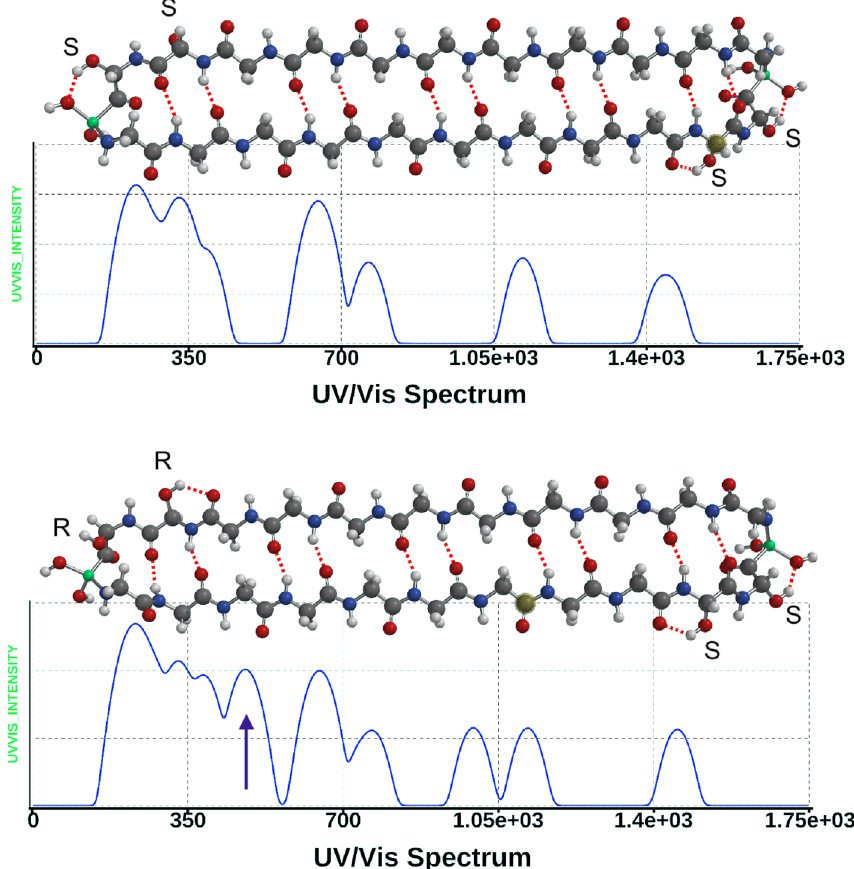
Figure 2. ( a ) (Top) UV/visible/IR spectra from the core polymer where the 4 hydroxy-glycine units all have ‘S’ (sinister/laevo S/L) chirality. There is no absorption at 480 nm. Graph axes: Vertical; calculated transition strengths on a log 10 scale: Horizontal; wavelength (nm). The molecular model format is ball and spoke. Atom labels: hydrogen white, carbon black, nitrogen blue, oxygen red, iron green. ( b ) (Bottom) spectrum from